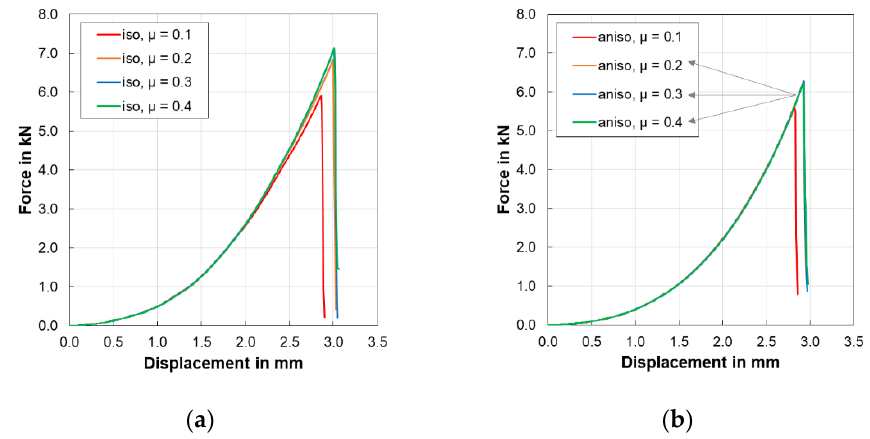
Figure 13. Force-displacement outputs with the homogeneous modelling method: ( a ) influence of coefficient of friction on isotropic model; ( b ) influence of coefficient of friction on anisotropic model.